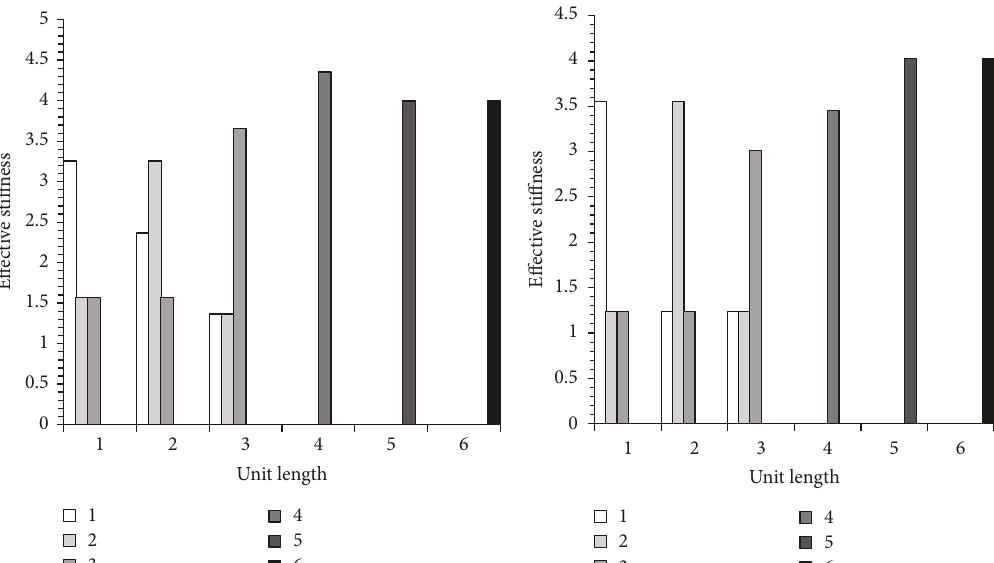
Figure 8: Effective stiffness of composites with fiber volume fraction of 10% and 30% at t � 0 s ( × 10 4 MPa).